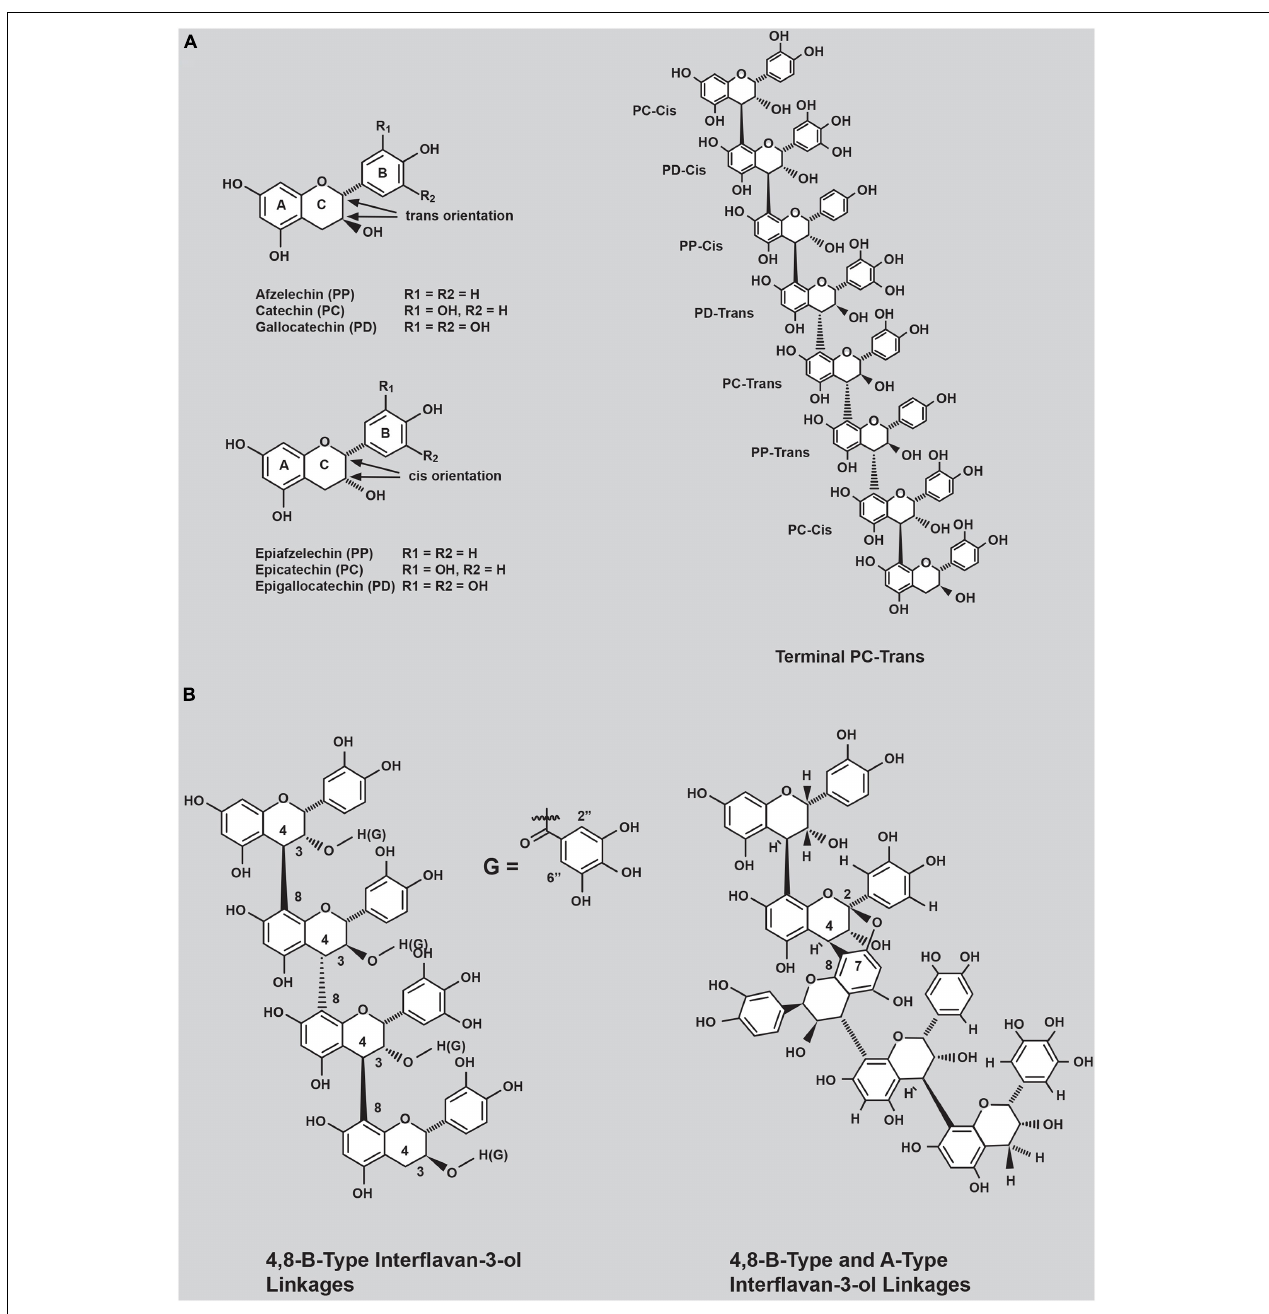
of the polyphenol anthocyanin, which is also derived from the phenolpropanoid pathway (Dixon et al., 2013; Albert et al., 2015). The expression of TaMYB14-1 in white clover germplasm containing the Tr-RED LEAF “R” locus should enable the accumulation of CTs in leaves at the required concentration ( > 1.5% of DM) for demonstrable effects on protein binding and methane emissions in rumen fluid in vitro . The transformation